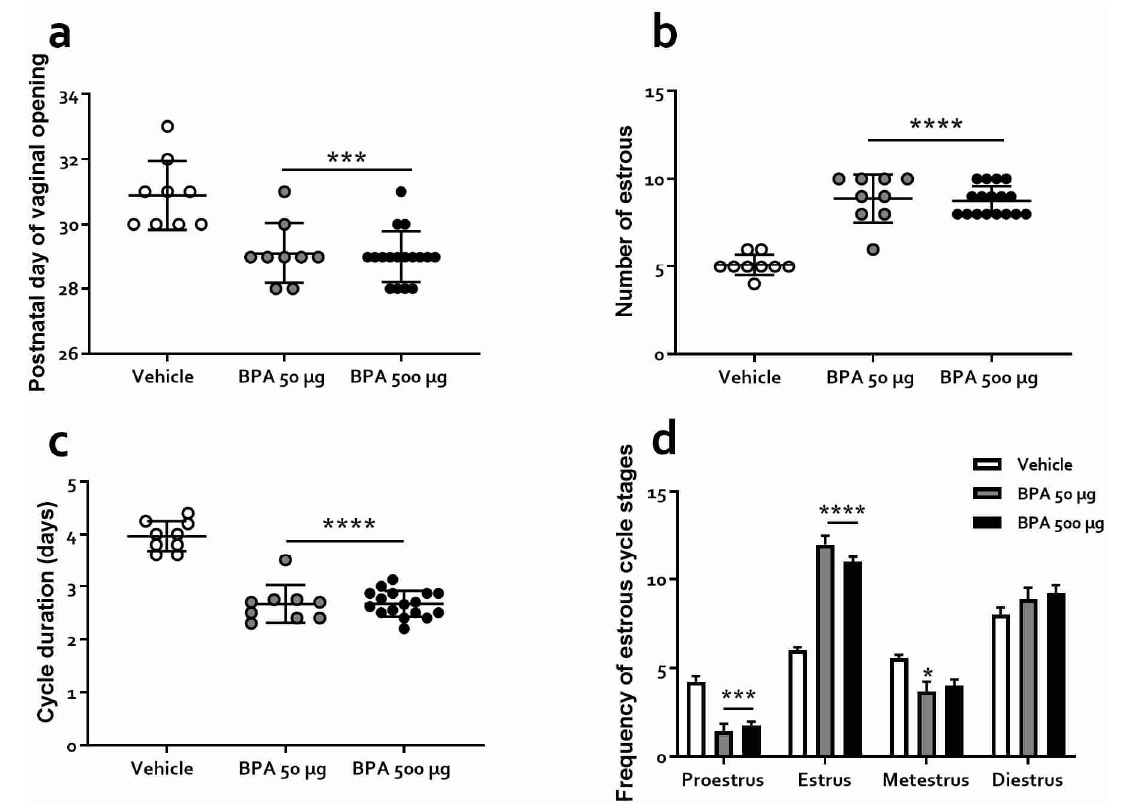
Figure 2. Effects of BPA on the estrous cycle of rats exposed during PND 28–54. ( a ) Onset of the estrous cycle (PND). ( b ) Number of cycles during the PND 28–54 period. ( c ) Length in days of the estrous cycle during the same period. ( d ) Frequency of each stage of estrous cycle. Results are represented as mean ± SEM ( n = 9). * p < 0.05; ***: p < 0.001; ****: p < 0.0001 vs. vehicle.